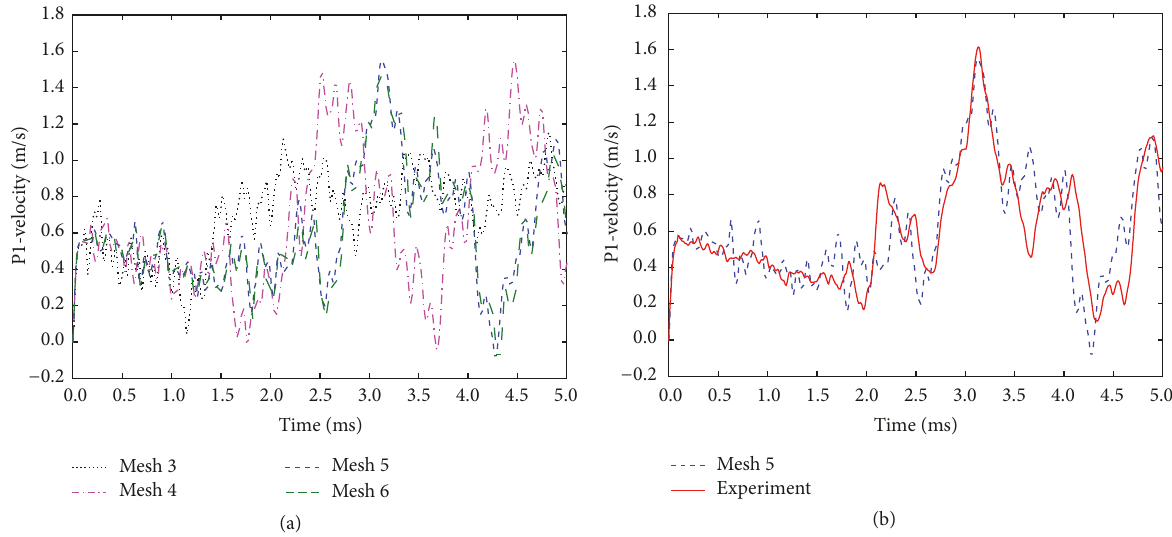
Figure 8: Velocity of point P1: (a) simulation results of further mesh refinements; (b) comparison between simulation using mesh 5 and